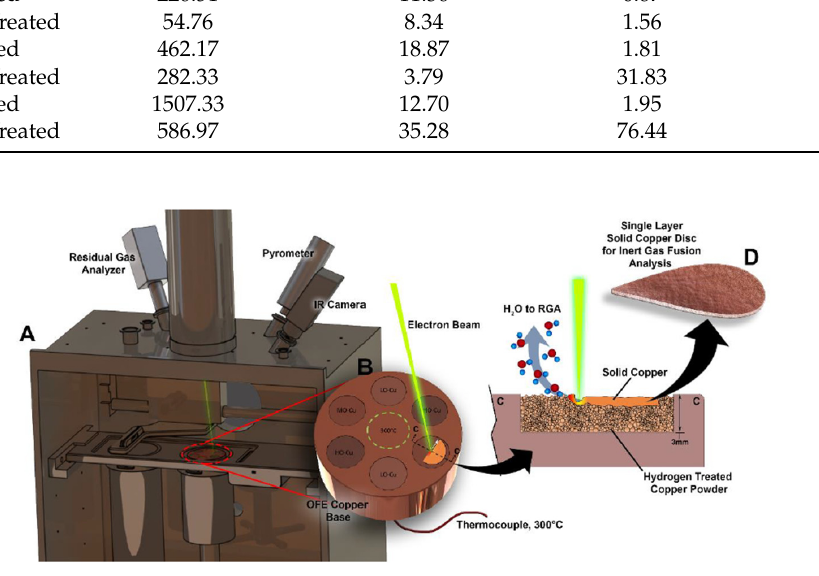
Figure 16. Description of in-situ H 2 O vapor outgassing experiment, ( A ) The diagram of the experimental instrument, ( B ) The base fixture contains six 3 mm deep pockets, ( C ) Powder melting process and detection, ( D ) The forming sample. Adapted from [6] MDPI, 2019.